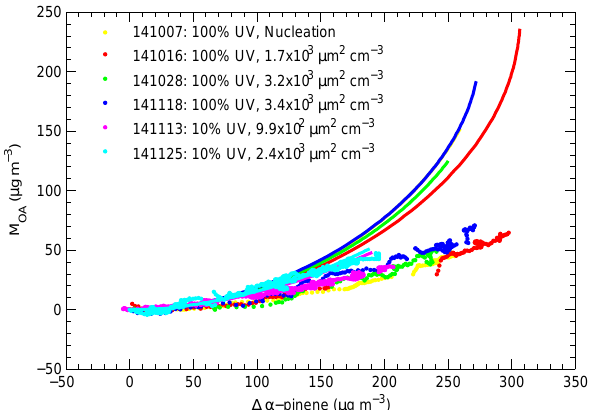
Figure 5. Mass of SOA as a function of reacted α -pinene. Ex- perimental data are shown with filled circles. Solid lines display GECKO-A predictions when using OH reaction rate constants that have been reduced to 10% of their default values (with the excep- tion of α -pinene + OH) and k gw = 10 − 5 s − 1